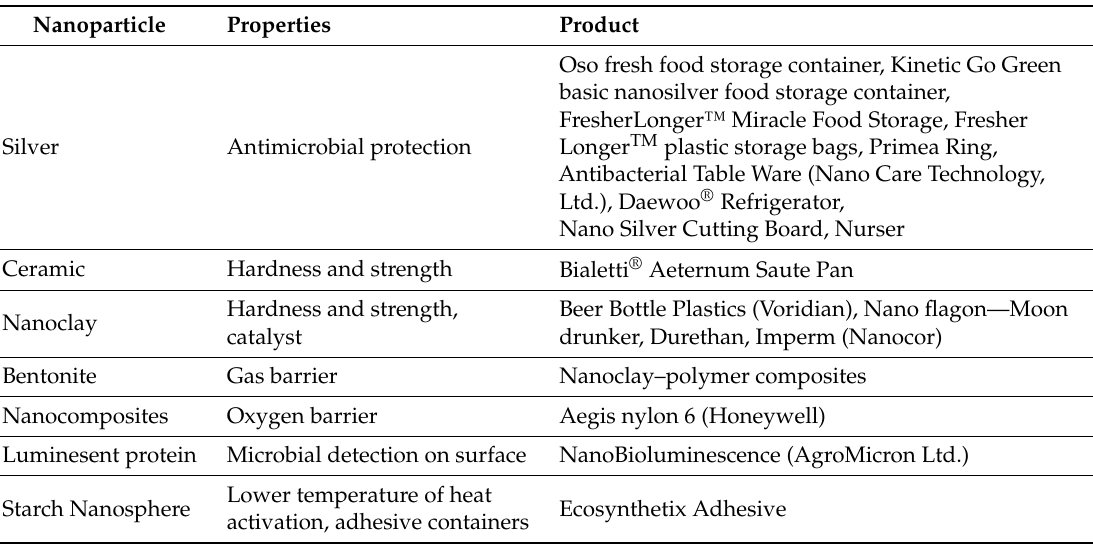
Table 2. Nanocomposite products for food contact